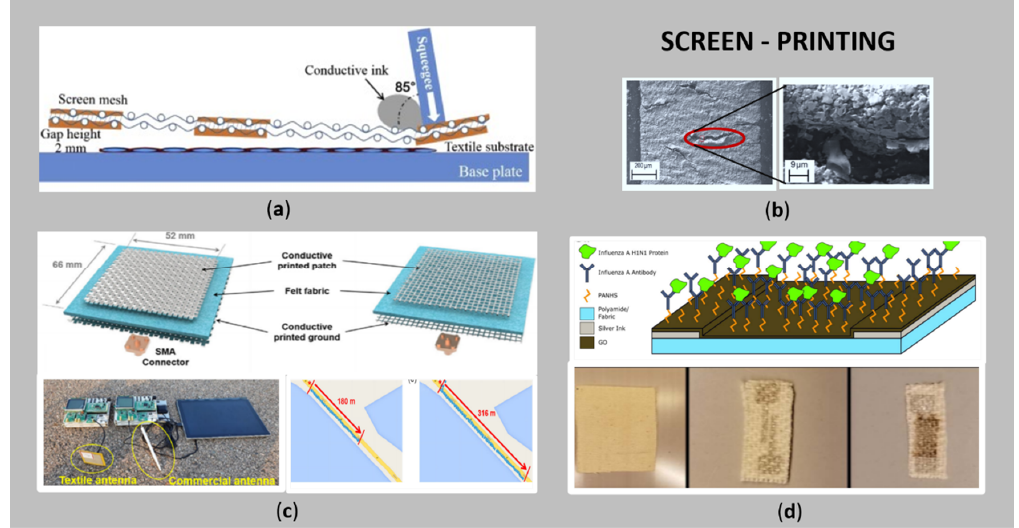
Figure 2. ( a ) Schematic diagram of screen printing in a cross-sectional view (reprinted with permission from Ref. [46] Copyright 2021 Elsevier); ( b ) a SEM image of printed Ag tracks on textiles (adapted from Ref. [47]); ( c ); schematic of textile patch antennas and their two-way Bluetooth communication system, using textile and commercial antennas (reprinted with permission from Ref. [48] Copyright 2021 John Wiley and Sons); ( d ) flexible screen-printed electrode on textile using Ag ink and a layer of graphene oxide (GO), and a schematic visualization cross-section showing the affinity assay for influenza (reprinted with permission from Ref. [35] Copyright 2021 IOP